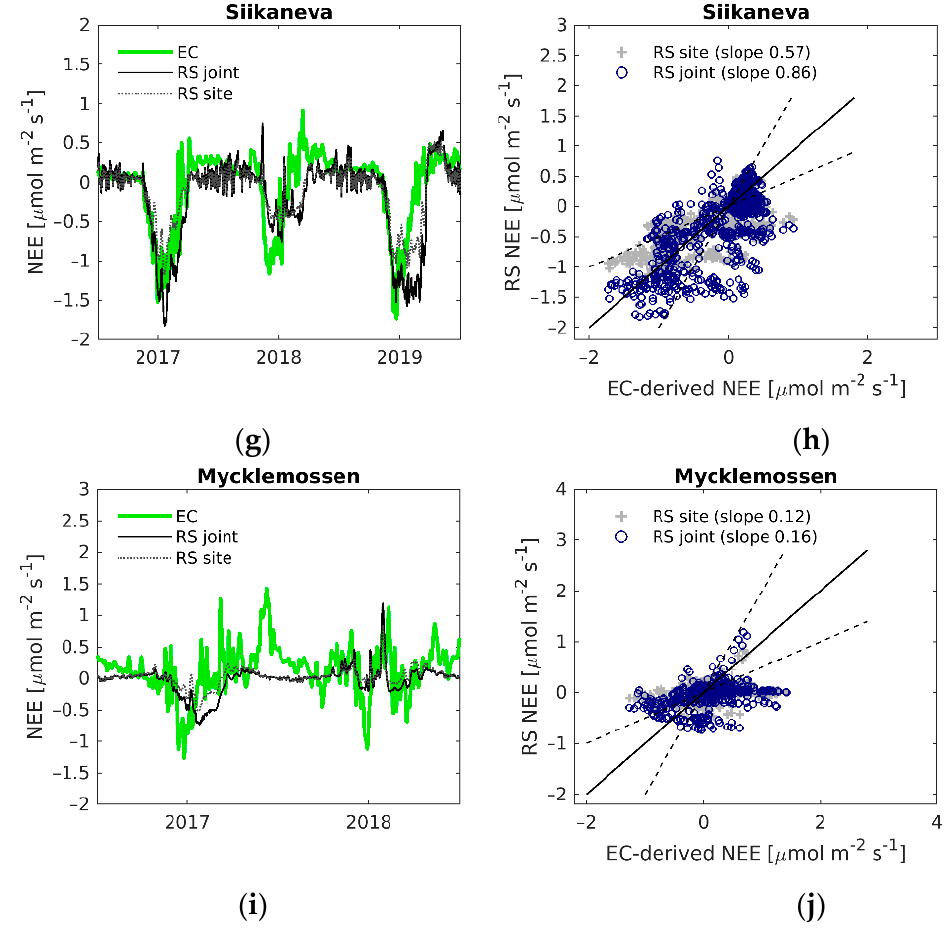
Figure 6. ( a , c , e , g , i ) Daily time series of EC-derived NEE (EC), modelled NEE using the LOOCV parametrization (RS joint) and modelled NEE with the site-specific parameters (RS site); ( b , d , f , h , j ) EC-derived NEE versus modelled remote sensing NEE. Black solid line is the 1:1 line, black dashed lines are the 1:2 and 2:1 lines.